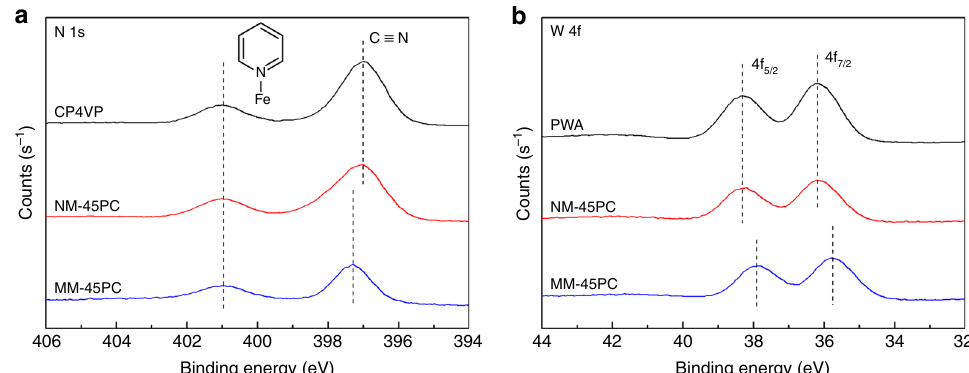
Fig. 4 Comparative X-ray photoelectron spectra. XPS narrow scans of N 1s and W 4f binding energy peaks for MM-45PC relative to membrane composition and NM-45PC are shown. a The N 1s scan of MM-45PC shows a positive shift for the cyano group relative to CP4VP and NM-45PC, indicative of a decreased electron density on the nitrogen of the cyano group. b The W 4f scan of MM-45PC shows negative shifts for 4f 7/2 and 4f 5/2 , indicative of the increased electron density on the PWA tungsten atoms. In combination, these shifts in binding energies demonstrate that under magnetic fi eld in fl uence, electron transfer and an interaction occur between CP4VP and PWA in MM-45PC (dashed lines are used to guide the eyes). XPS: X-ray photoelectron spectroscopy; CP4VP: ferrocyanide-coordinated poly(4-vinylpyridine); PWA: phosphotungstic acid; NM-45PC: normal-cast membrane with 45 wt% loading of proton-conducting components; MM-45PC: magnetic-cast membrane with 45 wt% loading of proton-conducting components. Source data are provided as a Source Data fi le